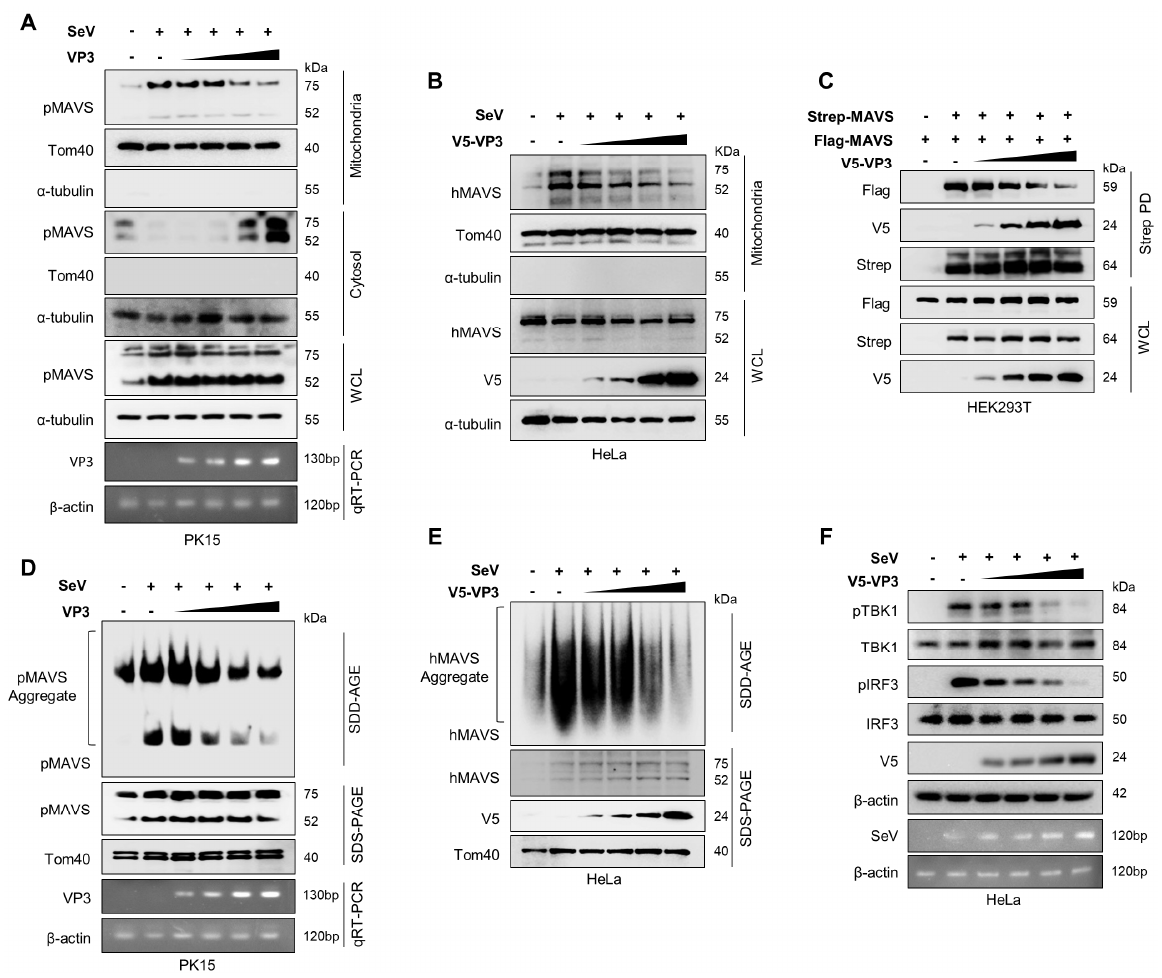
Figure 4. FMDV VP3 disrupts MAVS activation. ( A , B ) Immunoblot analysis of mitochondria fraction isolated from the ( A )